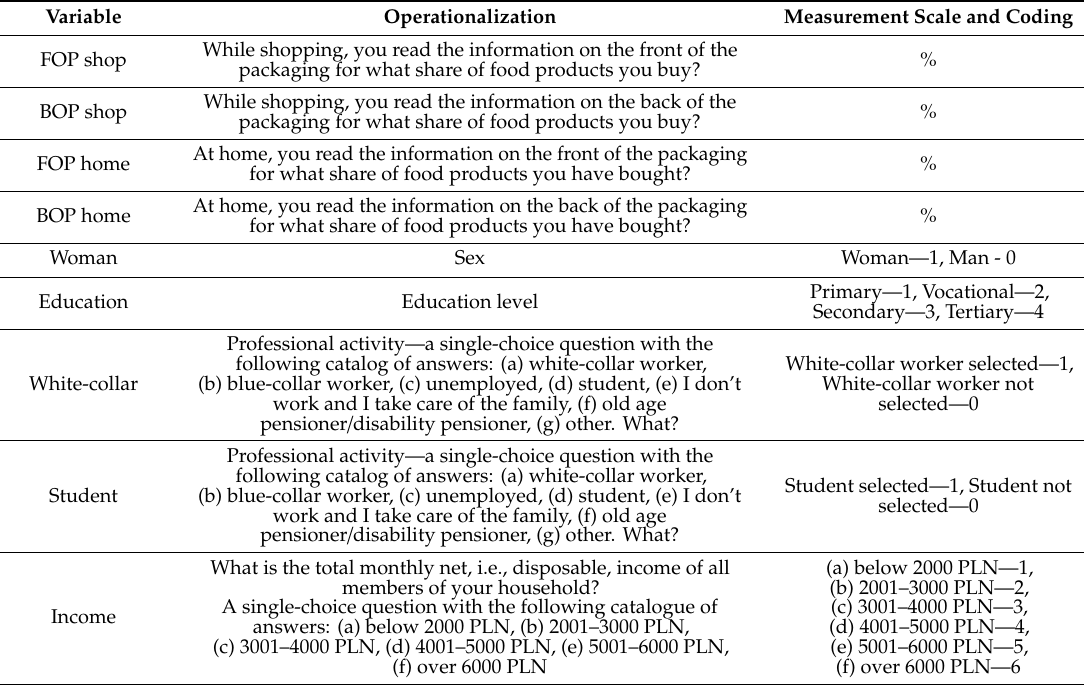
Table A2. The operationalization of key variables used in this